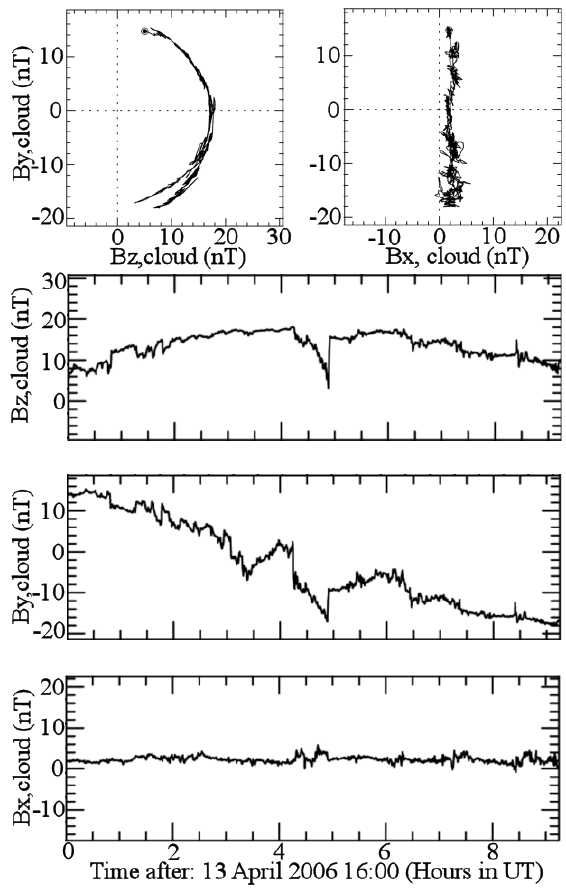
Fig. 2. Magnetic field components in local magnetic coordinates from the minimum variance analysis performed over the duration of the magnetic cloud (16:00UT 13 April 2006–01:15UT 14 April 2006). The two upper panels show the hodograms for the MC. The upper left panel shows the coherent rotation, while the upper right panel shows the noise in the x, cloud direction. The lower three panels show the evolution of the magnetic field components (with the orientation of the cloud given by the minimum variance method, see Sect.